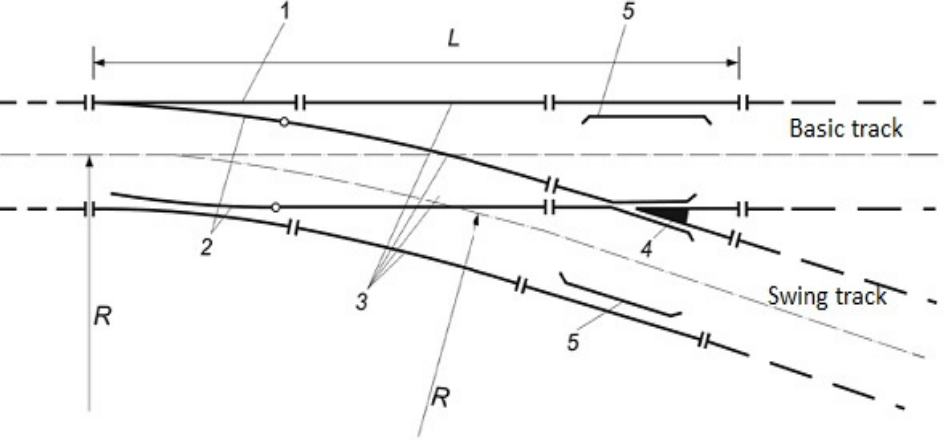
Figure 1. Normal right turnout 1—Stock rail, 2—Switch blades, 3—Closure rails, 4—Frog, 5— Guardrail .